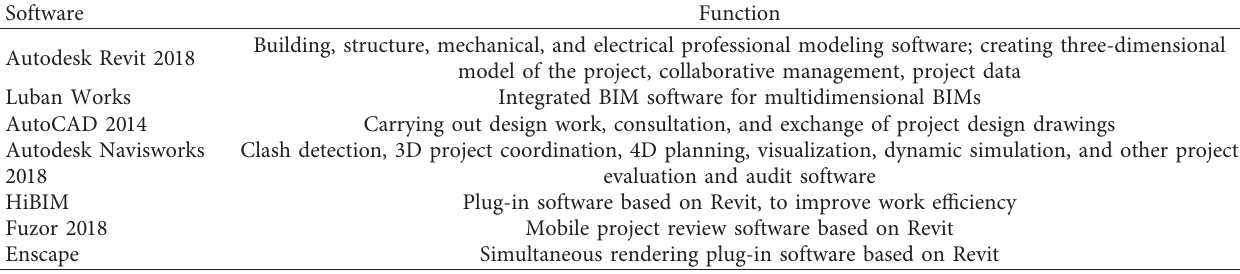
Table 1: BIM software.